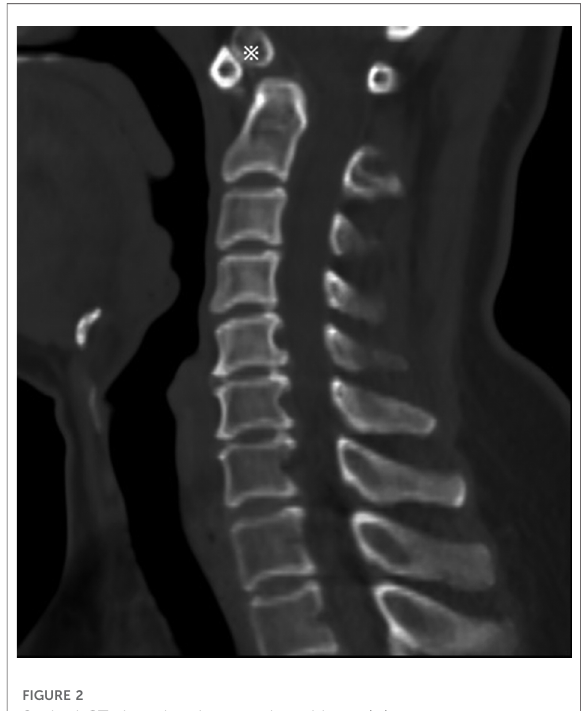
FIGURE 2 Sagittal CT view showing os odontoideum ( ※